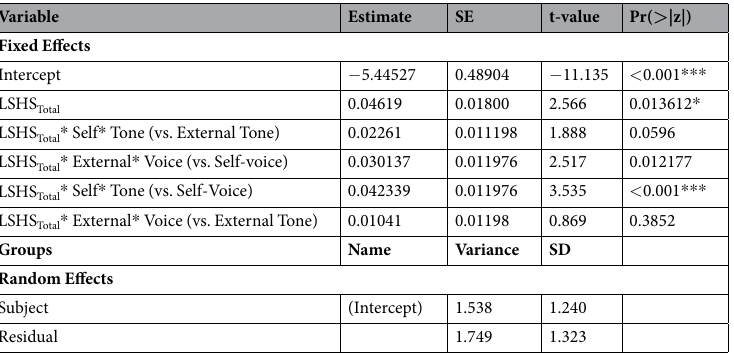
Table 1. Linear mixed effects model of N1 amplitude including the effect of hallucination predisposition. Notes . SE = standard error; SD = standard deviation; * p < 0.05; ** p < 0.01; *** p < 0.001. Degrees of freedom for Fixed Effects: df = 480.00 (except Intercept: df = 50.01).